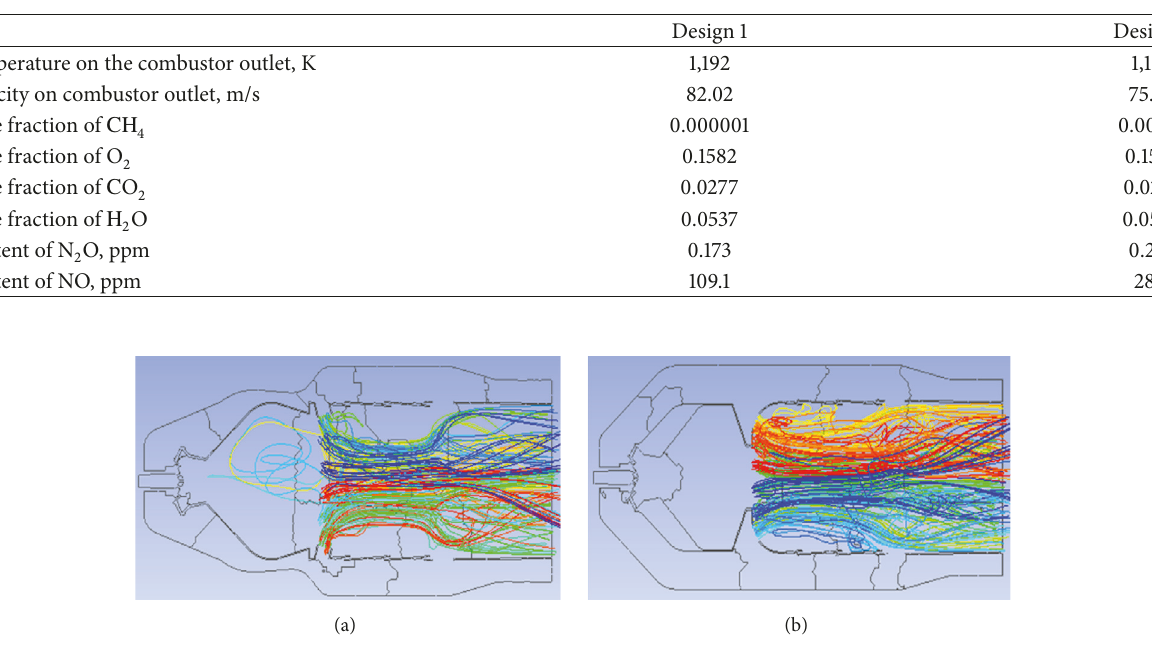
Table 6: Results of modeling of modified combustor designs operating on synthesis gas.